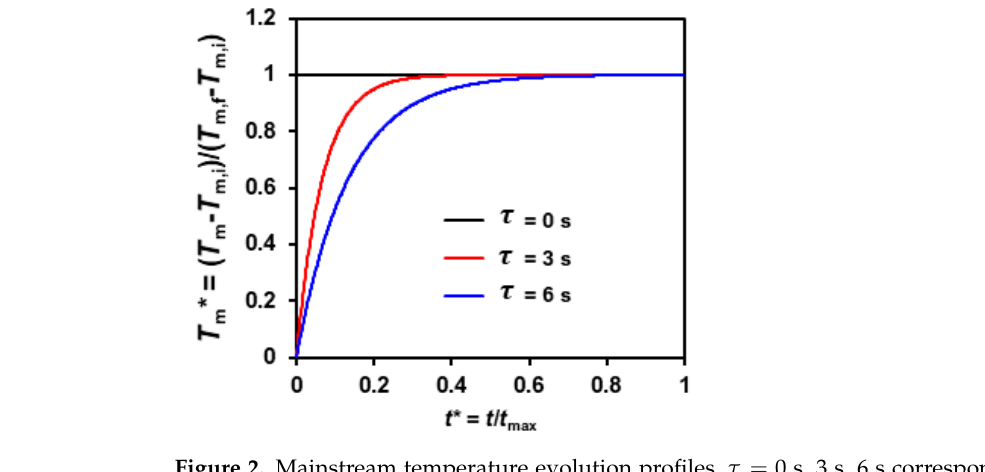
Figure 2. Mainstream temperature evolution profiles, τ = 0 s, 3 s, 6 s correspond to typical step change, moderately fast transient, and slow transient experiments. Table 1. Details of data reduction